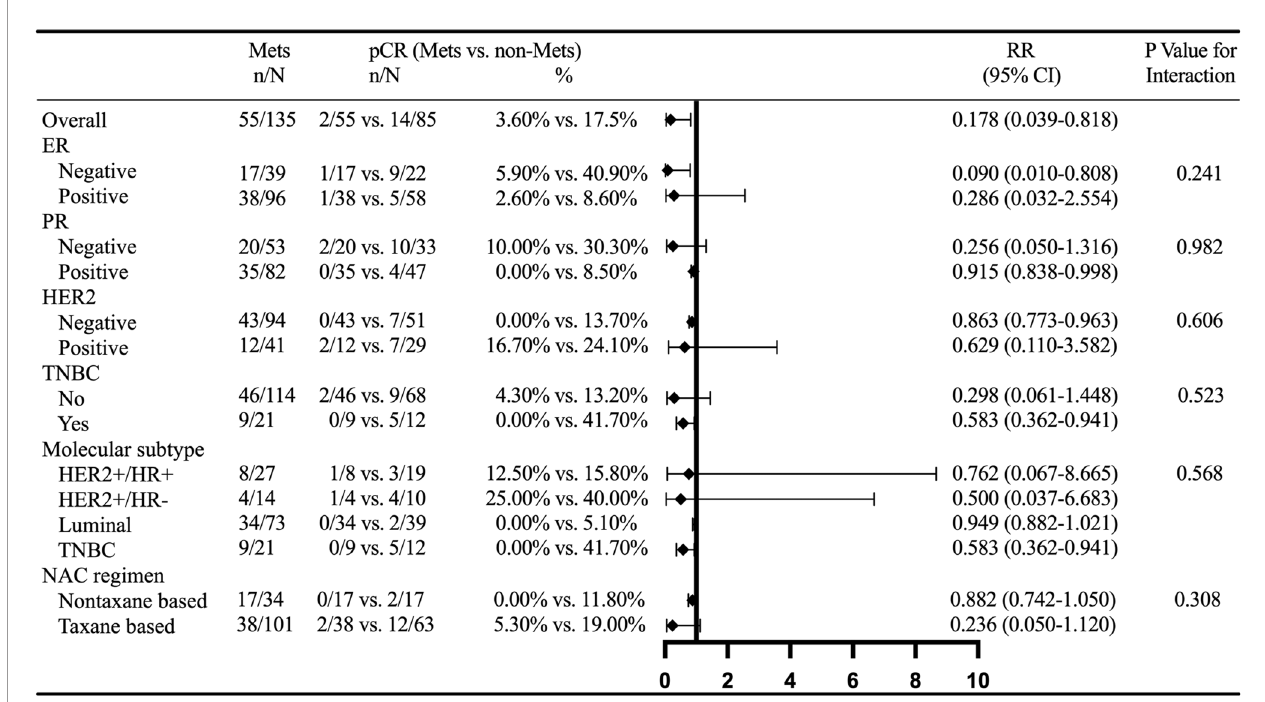
FIGURE 6 | External validation of subgroup analysis on the relationship between MetS and BCNACT pCR. MetS, metabolic syndrome; pCR, pathologic complete response; RR, risk ratio; CI, con fi dence interval; ER, estrogen receptor; PR, progesterone receptor; HER2, human epidermal growth factor 2; TNBC, triple negative breast cancer; NACT, neoadjuvant